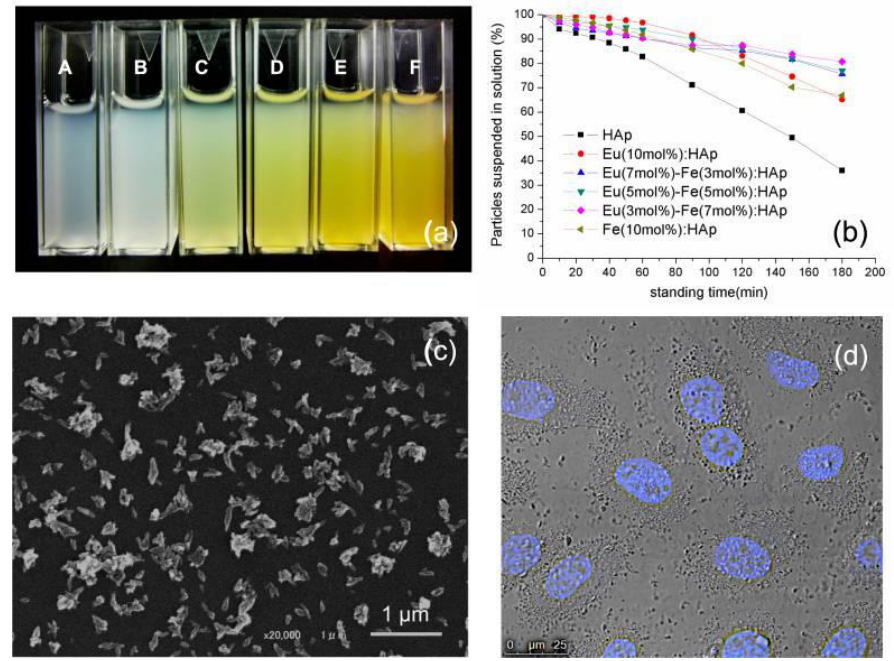
Figure 11. ( a ) Re-suspended HA and Eu/Fe:HA particles in a culture medium with 10% FBS (fetal bovine serum)-A-HA; molar ratios of Eu 3+ to Fe 3+ from B to F: 1:0, 2:1, 1:1, 1:2, and 0:1. ( b ) Assessment of particle suspension in a culture medium by turbidity measurement at 320 nm. ( c ) SEM image of Eu (5 mol %)-Fe (5 mol %):HAp. ( d ) cells incubated with Eu (5 mol %)-Fe (5 mol %):HA; (cell nucleus—Hoechest stain) [38] .